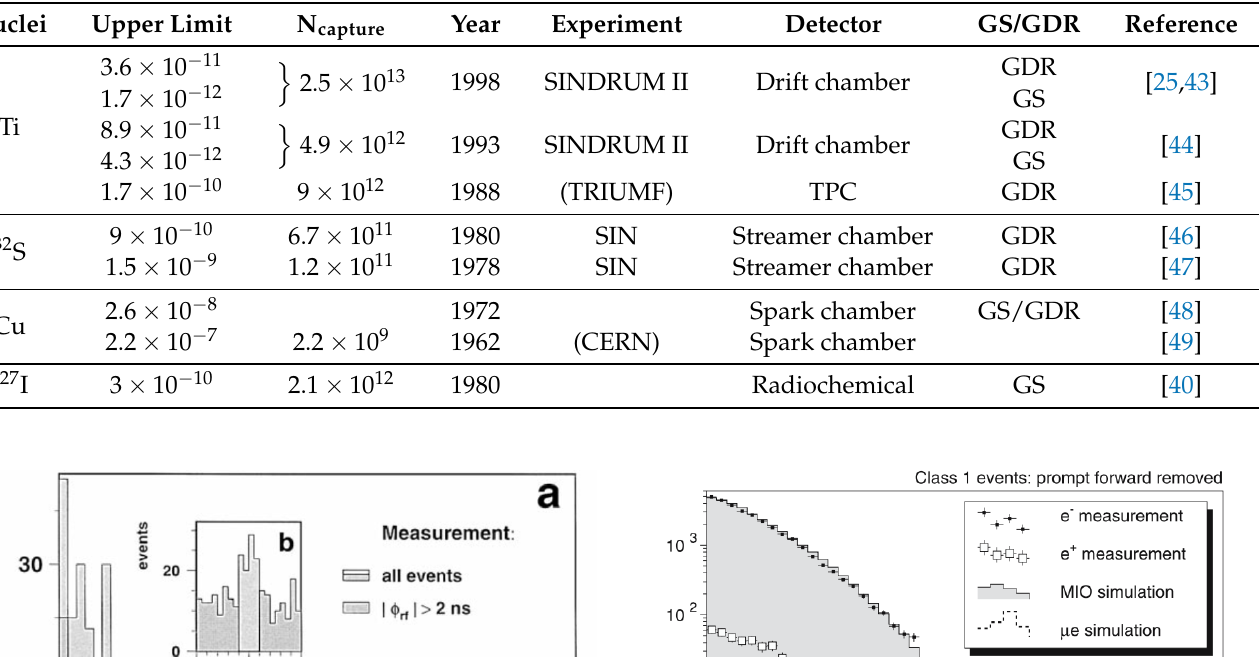
Table 1. The past µ − → e + experimental results[39]. The limits are quoted at 90% CL, and N capture is the number of muon captures in the experiments. GS and GDR represent ground state and giant dipole resonance excitation of the final nucleus status. While the natural abundance of 32 S and 127 I among their isotopes are almost 100%, Ti and Cu are not, which is the reason for not specifying the mass of Ti and Cu.